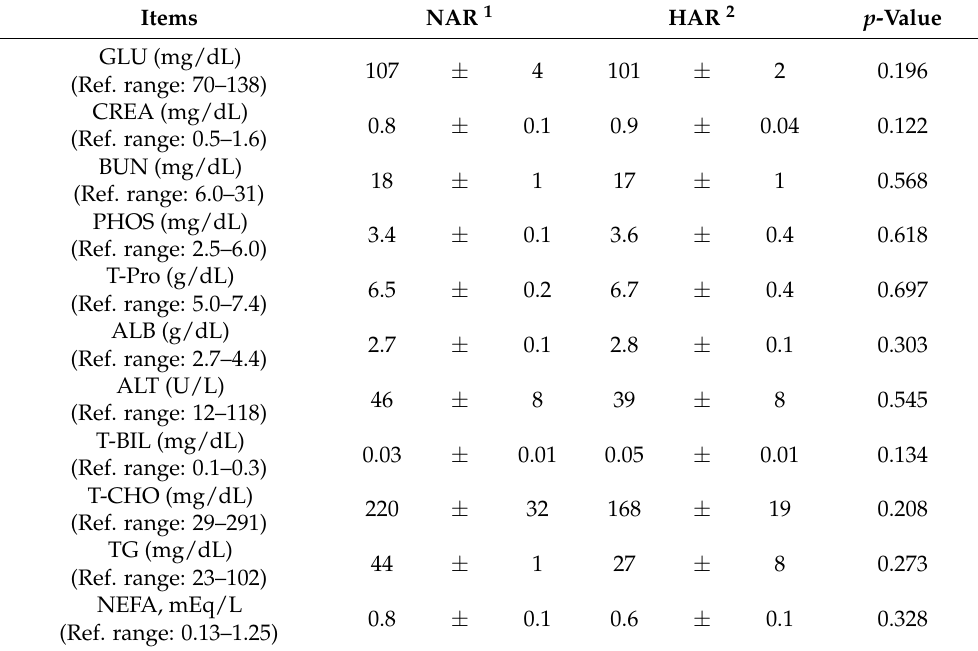
Table 8. Effects of high amylose type rice on serum biochemical parameters in dogs (Exp.